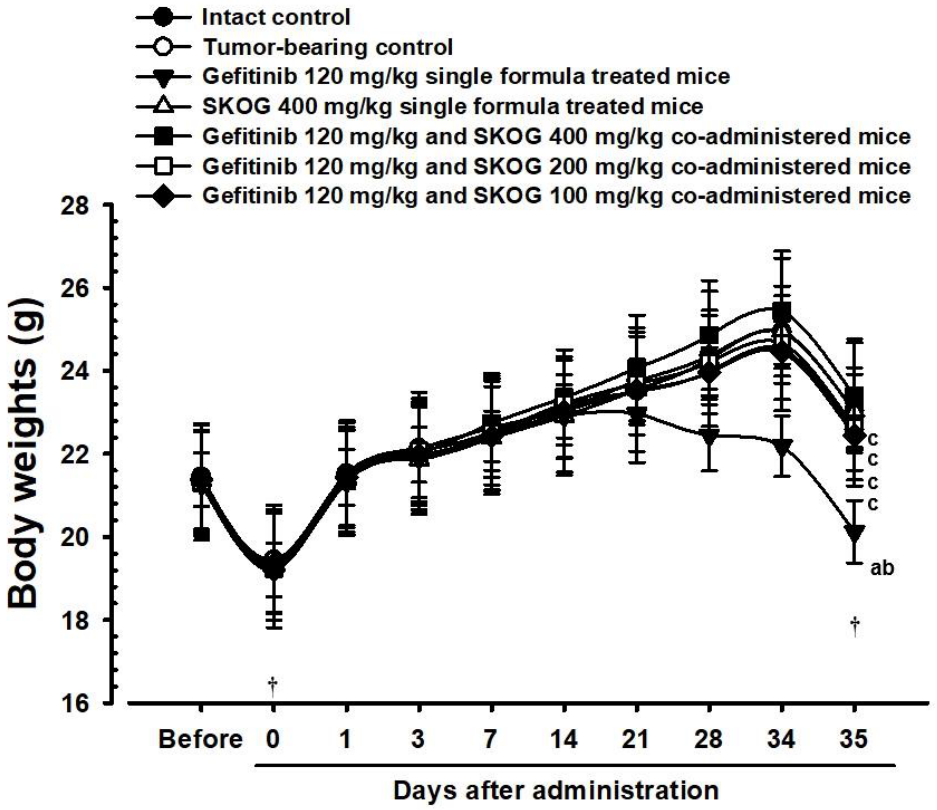
Figure 2. BW changes in NCI-H520 tumor cell xenograft mice. AR = Adenophorae Radix; KOG = Kyeongokgo ; SKOG = sasam-Kyeongokgo . Before means 1 day before the initiation of administration at day 13 day after tumor implantation. Before sacrifice and the day of initiation of the treatment, all the rodents were overnight fasted ( † ). a p < 0.01 versus intact control assessed by the Mann – Whitney U test; b p < 0.01 versus TB control, assessed by the Mann – Whitney U test; c p < 0.01 versus gefitinib-single-formula-treated rodents, assessed by the Mann – Whitney U test.